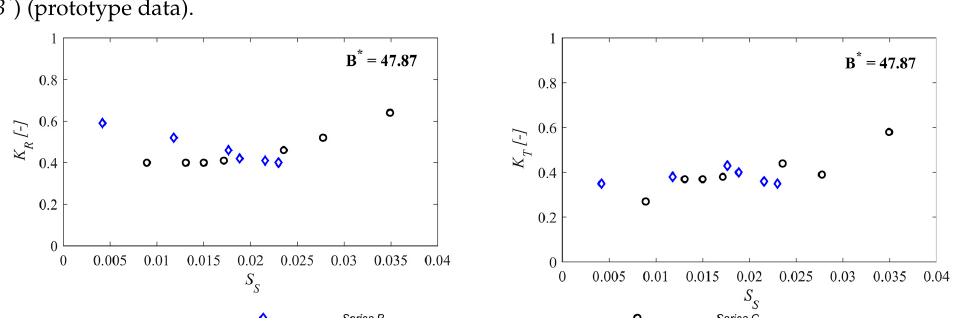
Figure 7. Variation of the reflection and transmission coefficients ( K R and K T ) with the significant wave steepness ( S S ) for irregular waves (Series B and C); and for the intermediate damping coefficient (prototype data).